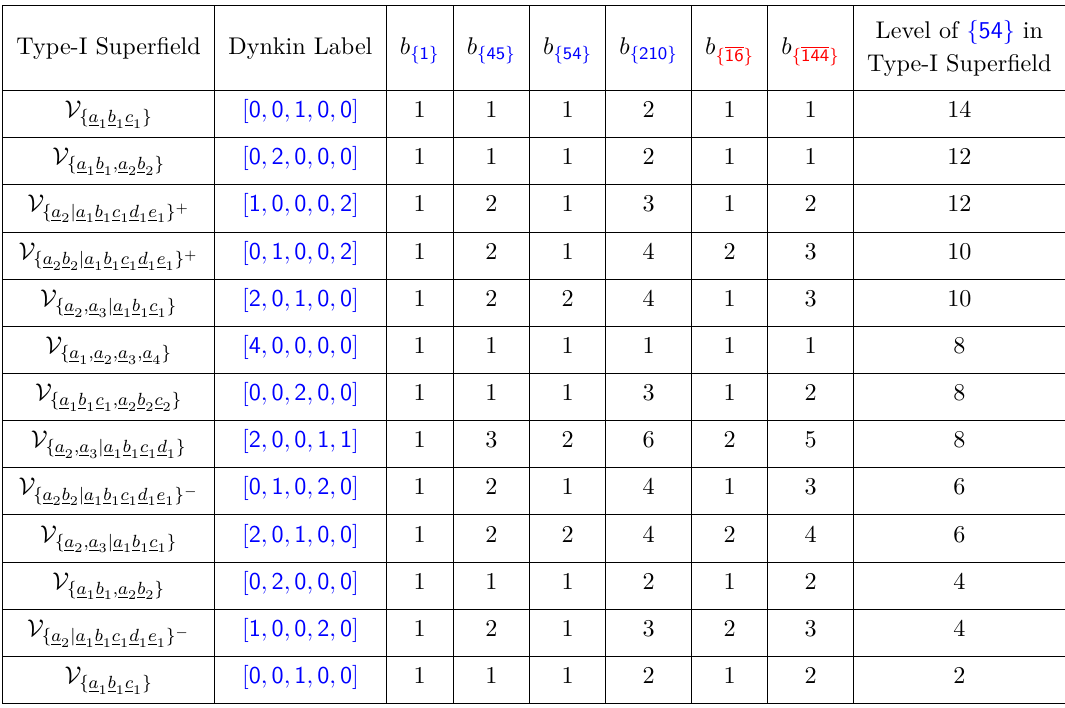
Table 3 . Contributions of Each Type-I Superfield to the component bosonic and fermionic rep- resentation content of the 10D, N = 1 supergravity multiplet at Level-16/17 of Type-IIB Scalar Superfield